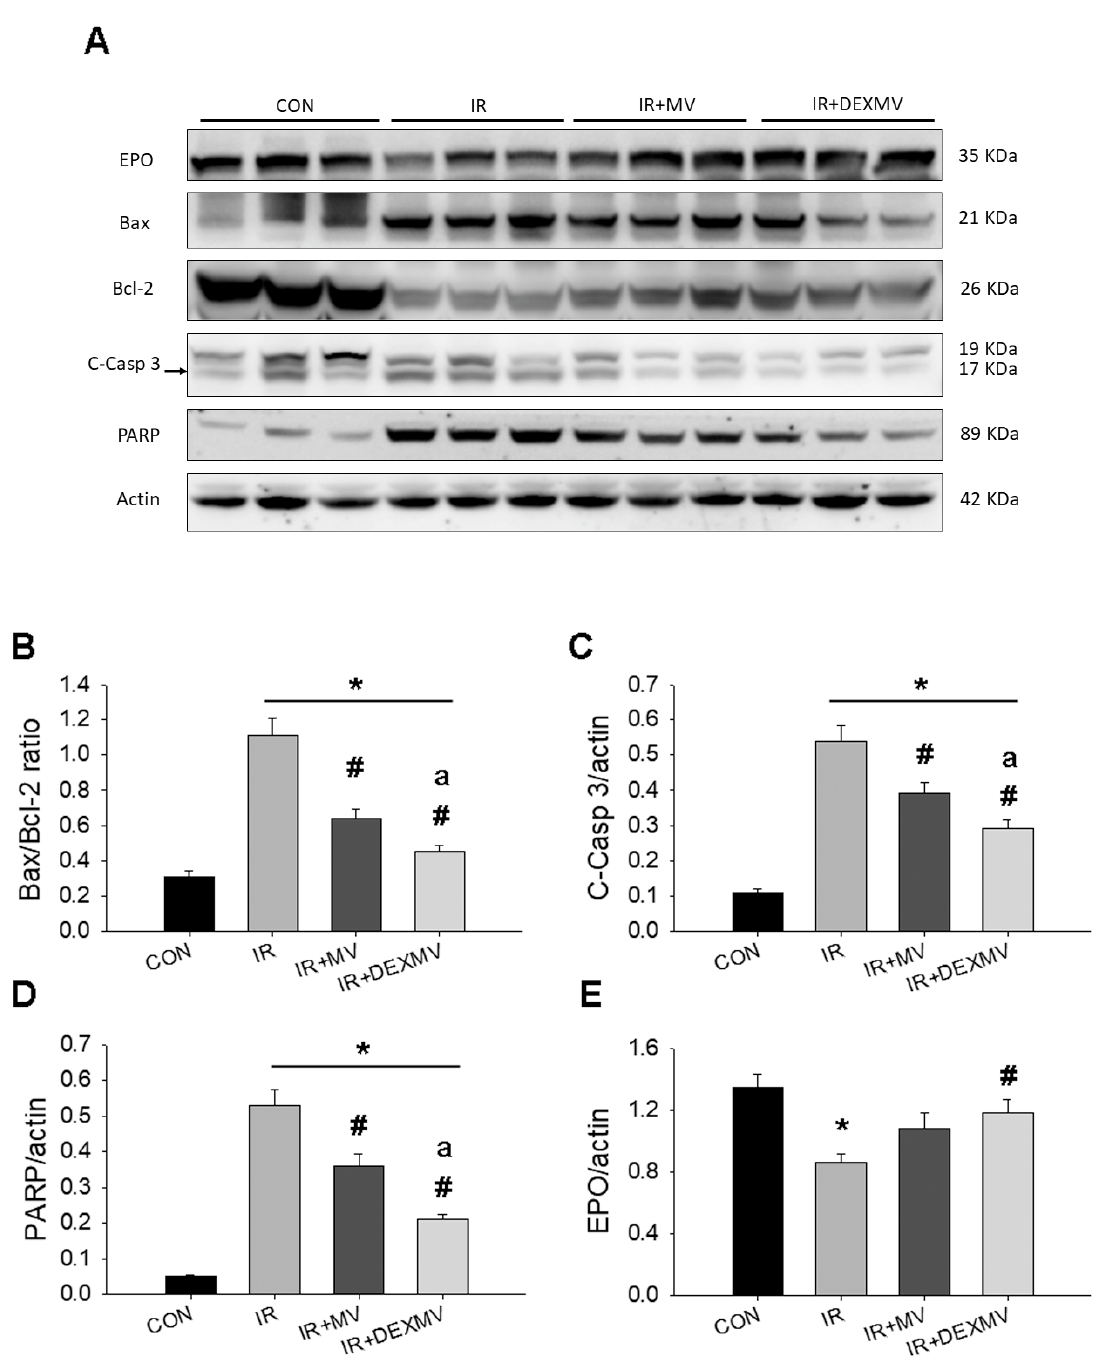
Figure 6. Effect of ADSC-derived MVs (IRMV) or DEX preconditioning ADSC-derived MVs (IRD- EXMV) on Bax, Bcl-2, cleaved caspase-3 (c-caspase-3), PARP, and EPO expression in the four groups of kidneys. ( A ): The original data of Western blot. ( B ): Statistical data of the ratio of Bax/Bcl-2. ( C ): Statistical data of the ratio of C-Casp 3/actin. ( D ): Statistical data of the ratio of PARP/actin. ( E ): Statistical data of the ratio of EPO/actin. Data are expressed as mean ± SEM in each group (n = 3) using the single values. * p < 0.05 compared with CON group. ADSC, adipose stem cells; c-caspase- 3, cleaved caspase-3; EPO, erythropoietin; MV, microvesicle; IR, ischemia/reperfusion; IRMV, ische- mia/reperfusion with microvesicle; IRDEXMR, ischemia/reperfusion with dexmedetomidine pre- conditioned microvesicle; PARP, poly-(ADP-ribose)-polymerase; SEM: standard error mean. # p < 0.05 compared with IR group. a p < 0.05 compared with IR+MV group.